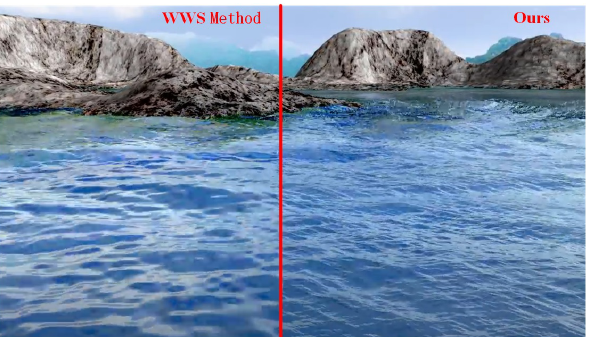
Figure 9. High-frequency detail comparison between the WWS [8] method and our method.